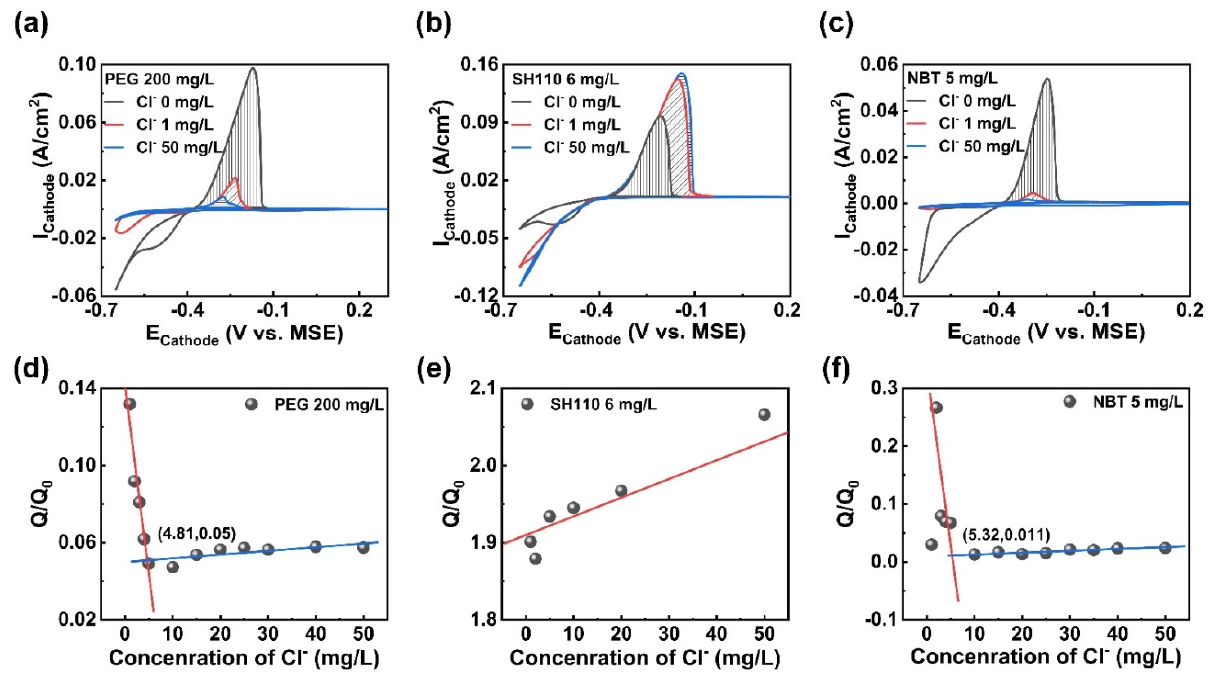
Figure 2. CV measurements of the electroplating solution containing: ( a ) PEG, 200 mg/L; ( b ) SH110, 6 mg/L; ( c ) NBT, 5 mg/L; ( d – f ) Q/Q 0 as a function of Cl − concentration measured in ( a – c ).